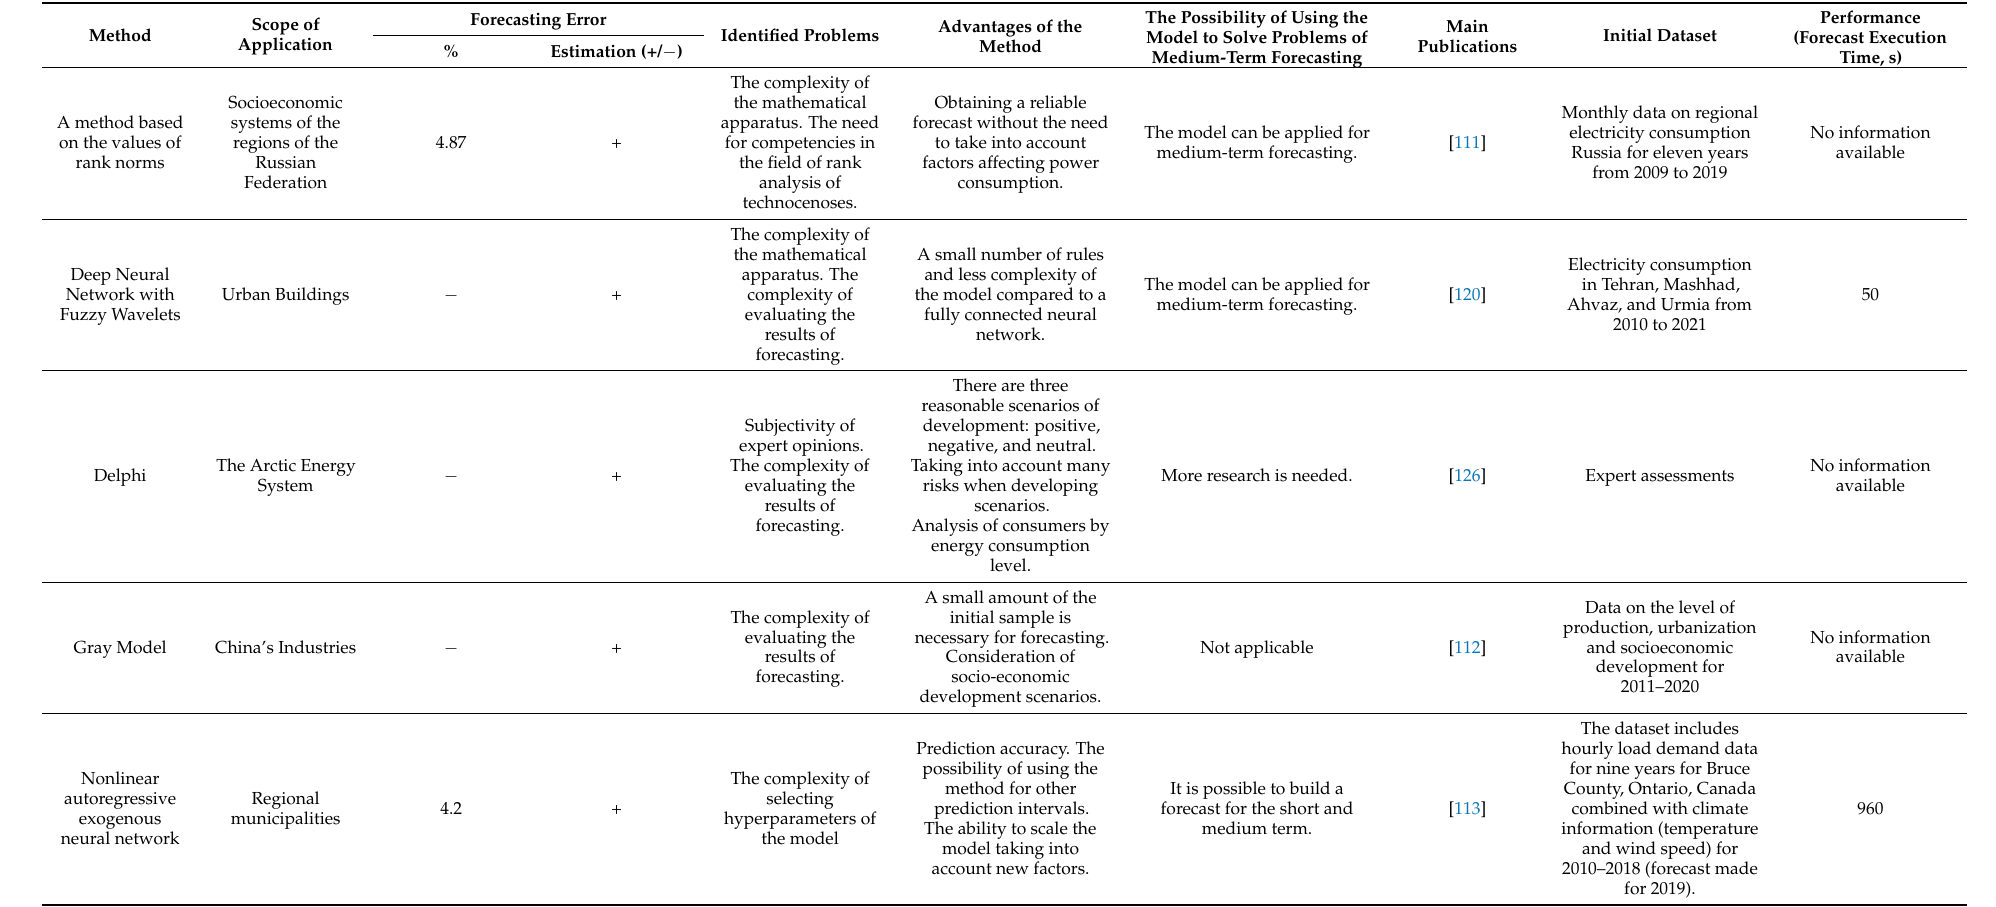
Table 4. Analysis of methods used in long-term forecasting of electricity